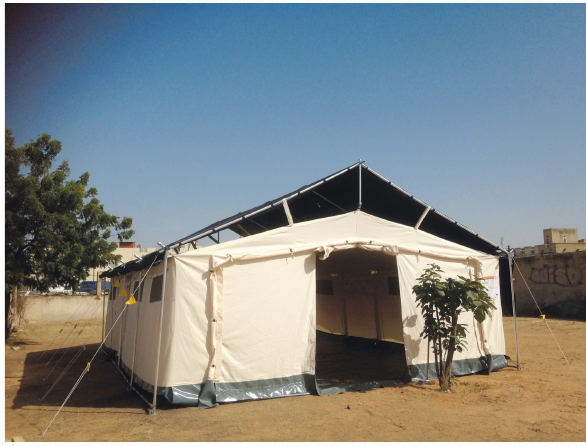
Figure 1: POLIMI and IFRC, T2 Multipurpose collective shelter